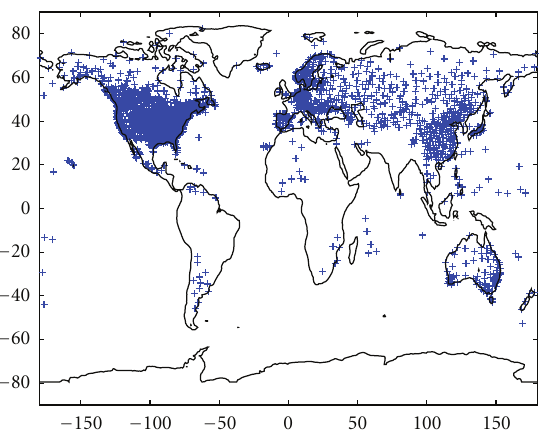
Figure 1: Locations of GHCN-Daily stations used.